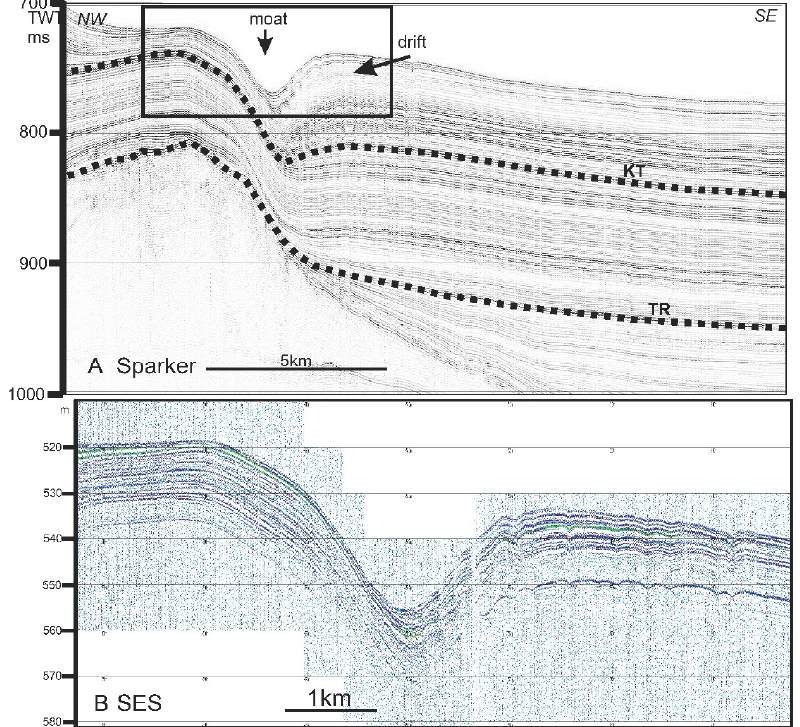
Figure 14. Contourite separated drift and deep erosional moat in the Derbent Basin off its eastern slope. ( A ) Fragment of the profile (sparker) NW-SE along foot of the slope which shows buried ancient creep deformation. Main unconformities: TR—Turkanian regression, KT—Khvalinian transgression. ( B ) Enlarged fragment of ultra-high-resolution seismic reflection profile (SES) showing in detail uppermost sedimentary layer with lens of the drift. Location in Figure